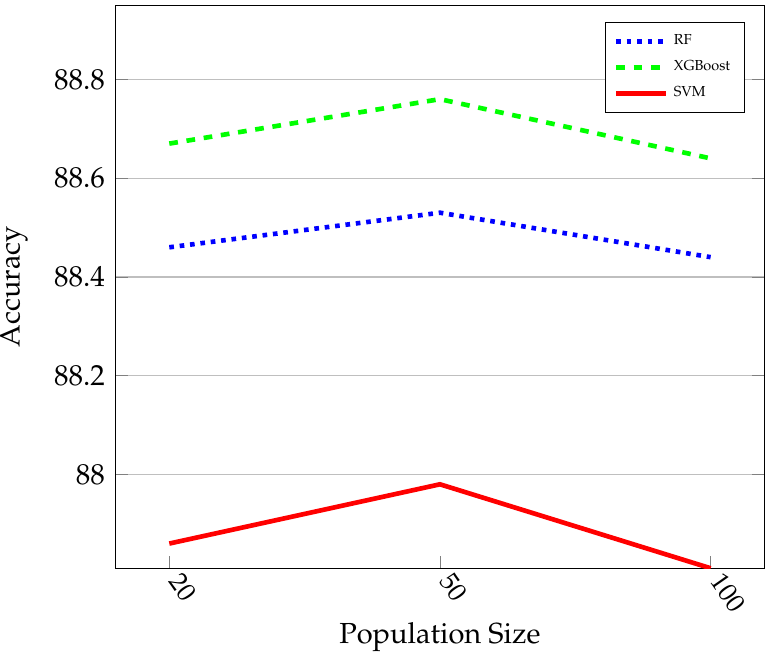
Figure 4. Impact of population size on classifier accuracy.